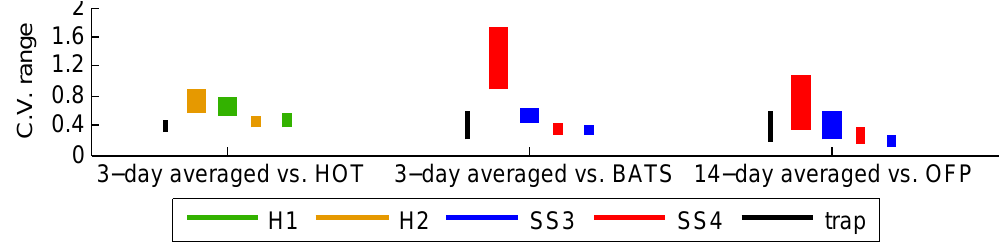
Fig. 7. Coefficient of variation (CV) ranges of log-transformed float and sediment trap time series data. Black lines show annual CV distri- bution from BATS, HOT, and OFP records. Each colored bar shows the 95% confidence range for the CV value of observations from floats with (thick bars) and without (thin bars) inclusion of the discontinuous flux component.